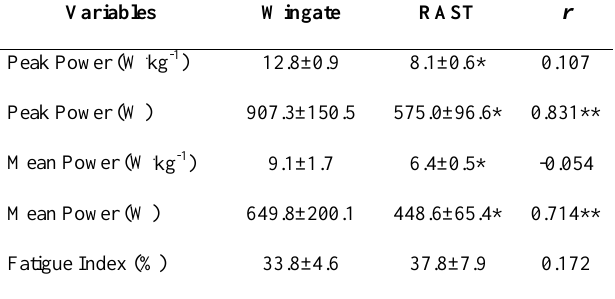
Table 1. Descriptive results (mean ± standard deviation) for peak power, mean power and fatigue index from Wingate test and